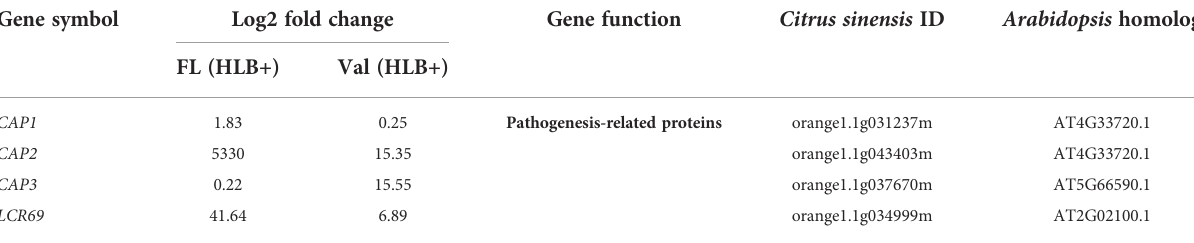
TABLE 4 DEGs involved in Cysteine-rich secretory proteins or Pathogenesis-related protein of Ca Las in fi nger lime and ‘ Valencia ’ sweet orange.